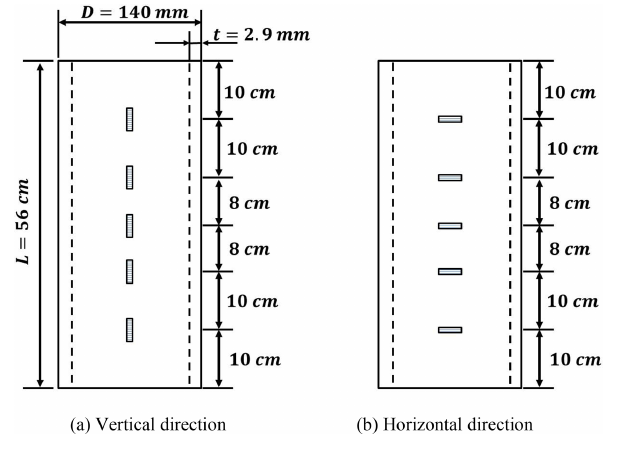
Figure 8. Gages on the Steel Tube.